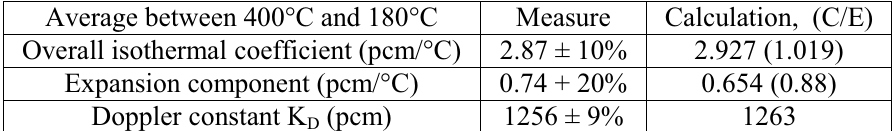
, and comparison to the values obtained from the measurements Table III. Evaluation of k and K D